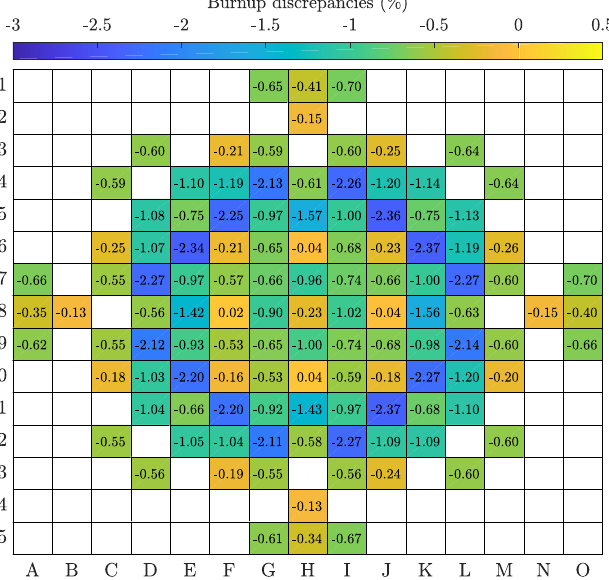
Fig. 7. Burnup discrepancies between predicted and calculated values at reloading.